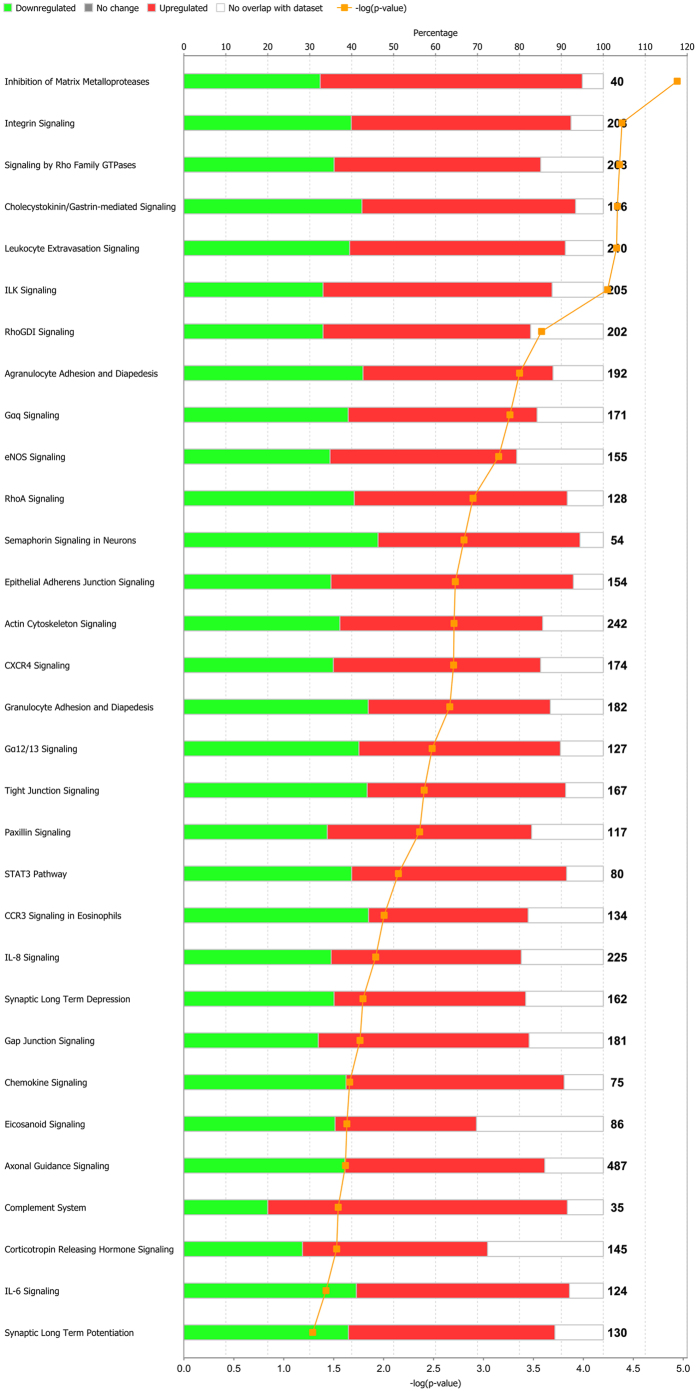
List of pathways sorted by enrichment P values, with specification of the percentage of up-regulated and down-regulated genes, when compared with the total number of genes known to participate in the pathways.The orange curve shows the ratio between the number of differentially expressed genes and the total number of genes in these pathways.